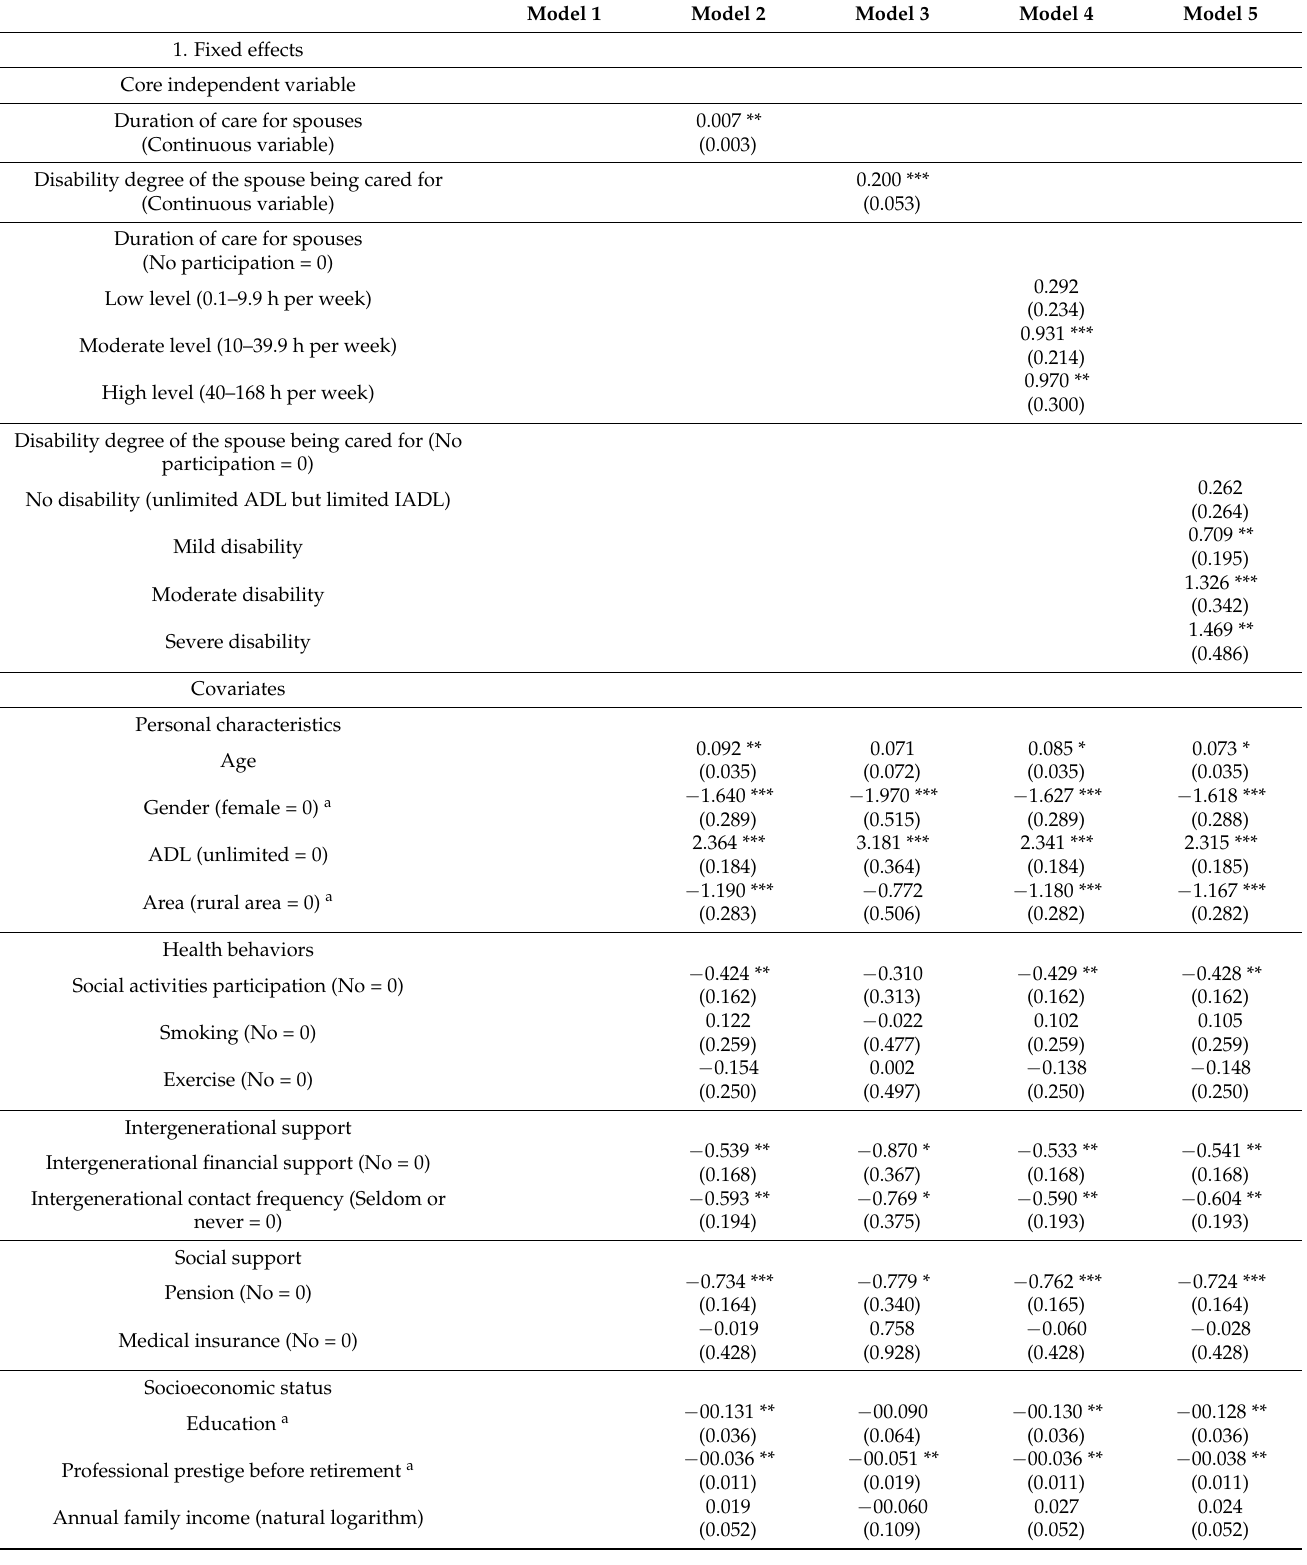
Table 4. MGM of the effect of spousal caregiving intensity on the depression level of the older